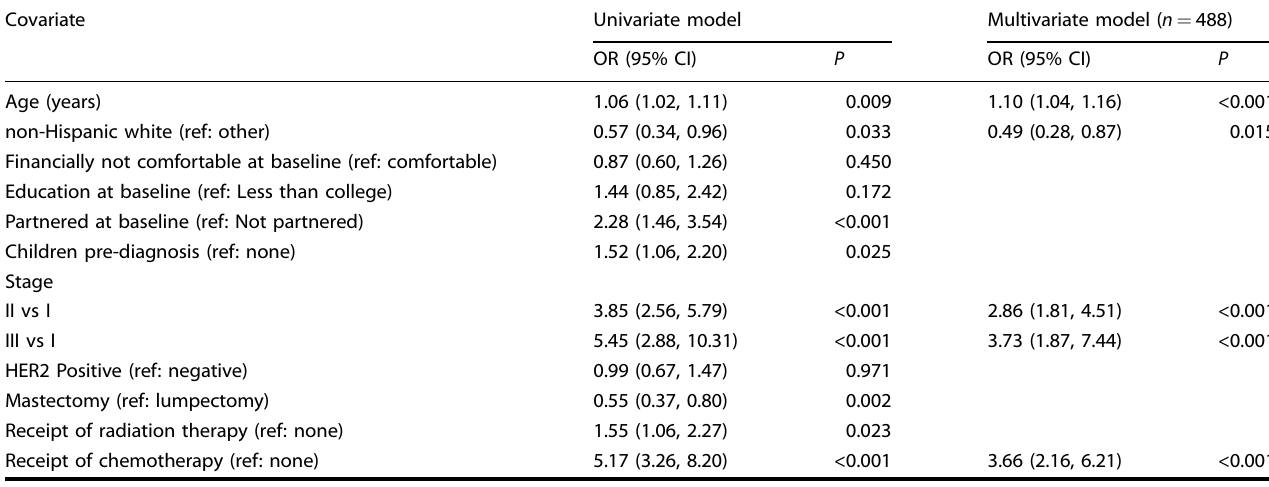
Table 2. Univariable and multivariable analysis of factors associated with extended endocrine therapy use.